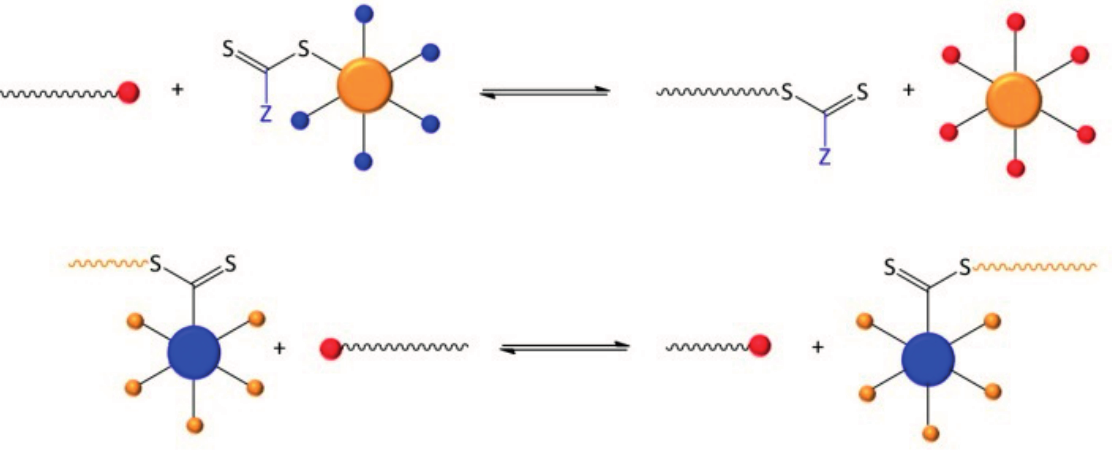
Figure 1. The R-group approach ( top ) and the Z-group approach ( bottom ) of star polymer synthesis via reversible addition-fragmentation chain transfer (RAFT) (red: radical functionalities; orange: R-group; blue: